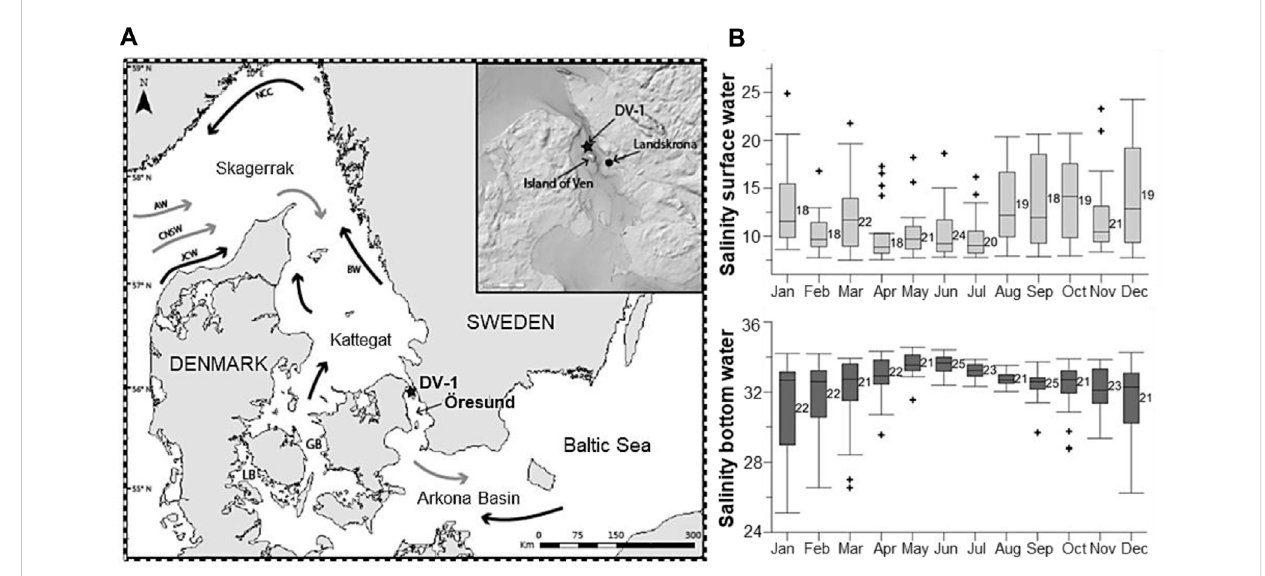
FIGURE 2 (A) Mapofthestudiedarea.ThestarshowsthesamplingstationDV-1locatednorthoftheIslandofVenintheÖresund.GB:GreatBelt;LB:LittleBelt. General water circulation includes main surface currents (black arrows) and main deep currents (grey arrows). AW: Atlantic Water; CNSW: Central North Sea Water; JCW; Jutland Coastal Water; NCC: Norwegian Coastal Current; BW: Baltic Water. (B) Seasonal variability of salinity (PSU) at the surface water (lightgrey)andthebottomwater(darkgrey).Thenumbersnexttothebarsindicatethenumberofmeasurementsforeachmonthbetween1965and 2016. Modi fi ed from Charrieau et al. (2019).